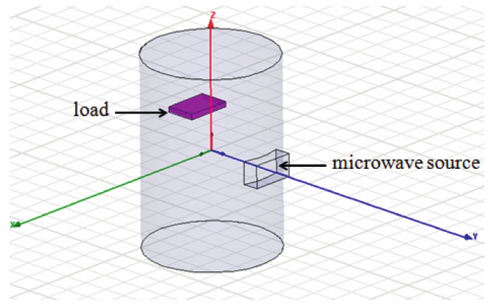
Figure 2: The diagram of the multi-mode cavity after optimization with specimen load.